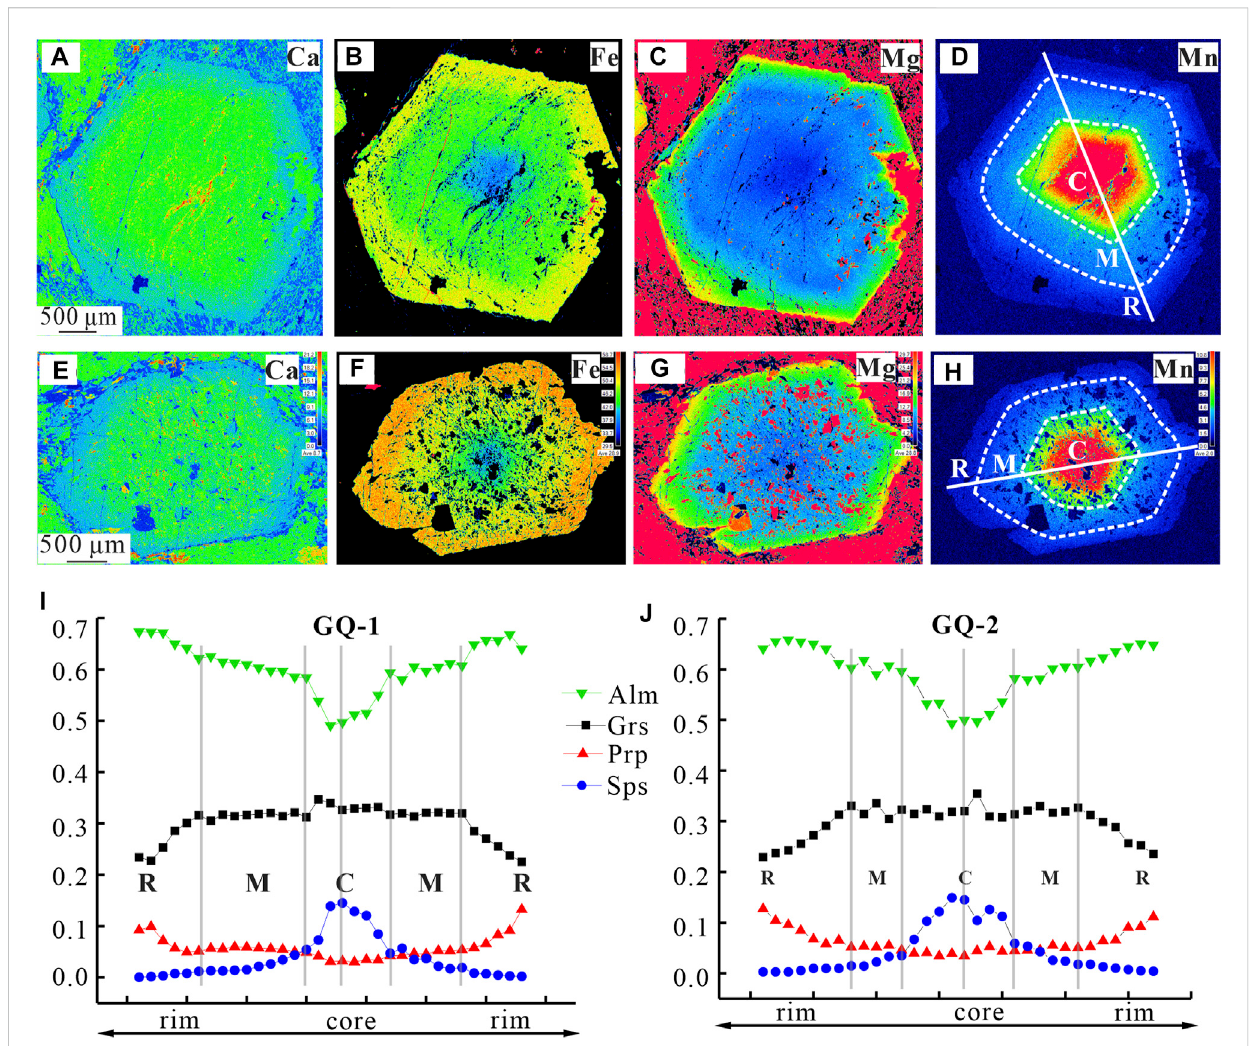
FIGURE 3 (A – H) X-ray element mapping for garnet from the eclogite GQ – 1 (A – D) and GQ – 2 (E – H) at Gaoqiao, western Dabie, respectively. (I,J) Travers of point analyses for garnet from the eclogite GQ – 1 and GQ – 2, respectively. (C) represents garnet core, M represents garnet mantle, R represents garnet